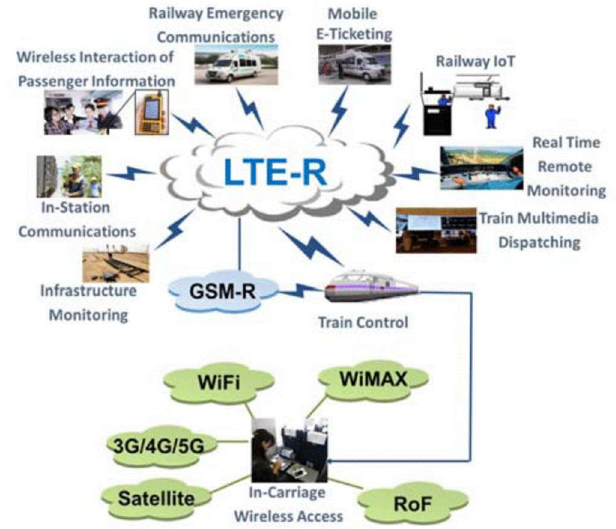
Figure 2. LTE-R services